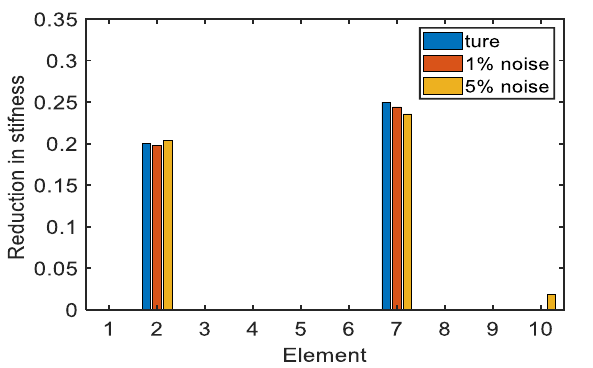
Figure 8. The identification results of the damaged case by MDBA under different noise conditions.